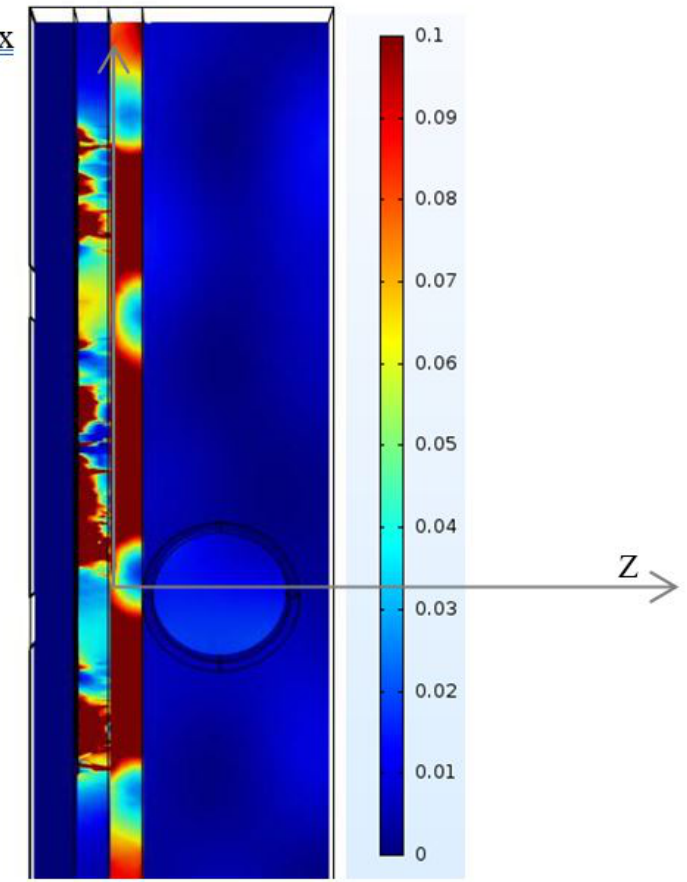
Figure 7. SAR distributions in the modeled phantom. The SAR can change from one person to another based on its tissue distribution and biological composition. The study of the local SAR on the tissue model of a thin person’s forearm is presented in Figure 8, and we notice that the local SAR in skin decreases in the same way as it does in the model with fat. This shows that skin behaves as a shield. Whatever the used tissue model is, the maximum of the SAR value is less than 1.4 W/kg, and the sensor meets the standard and it is comparable to some Industrial smartphones, indeed, some mobile phone brands exhibit an average SAR between 0.18 and 1.75